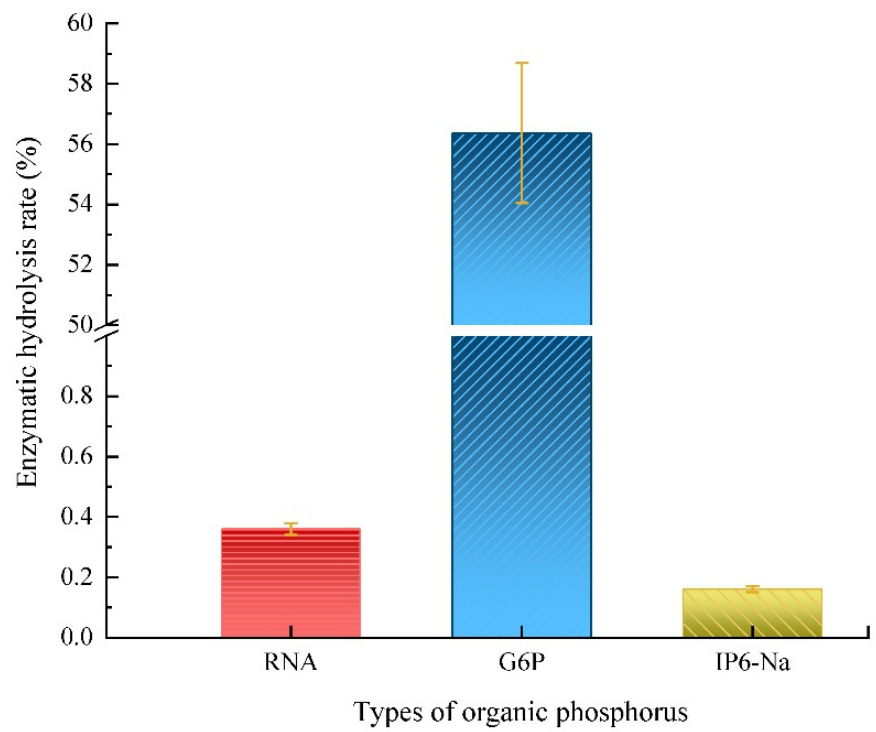
Figure 1. Mineralization of different organic phosphorus substrates (G6P, RNA, and IP6-Na) by PhoA.